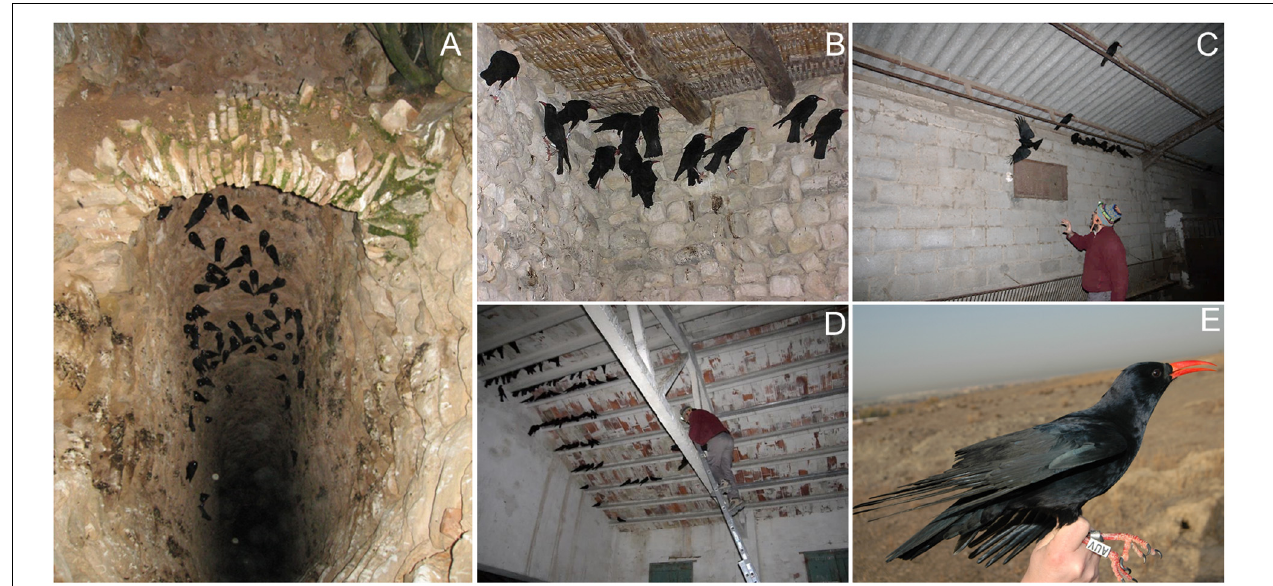
FIGURE 2 | (A) Example of a communal roost of red-billed choughs in a well (Cuenca province, Spain); (B) Details of the position of choughs after cornered them by human (experimental) predators, and (C) their capture by hand and (D) with the help of a ladder in communal roosts located in buildings in Aragón (Spain). (E) A red-billed chough after marked with rings for individual identification. Photo credits: A (J. A. Cuevas), B (G. Blanco), C,D (J. M. García), E (Ó.